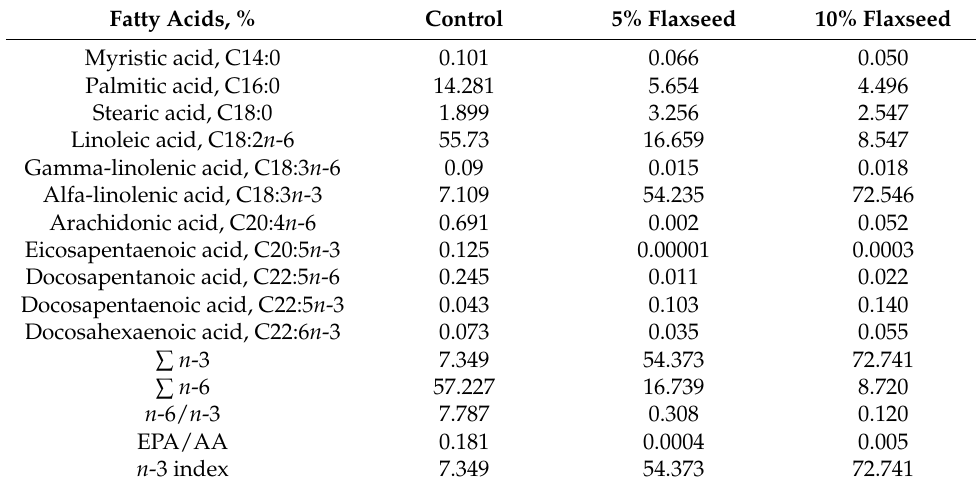
Table 3. Fatty acid composition of control and experimental